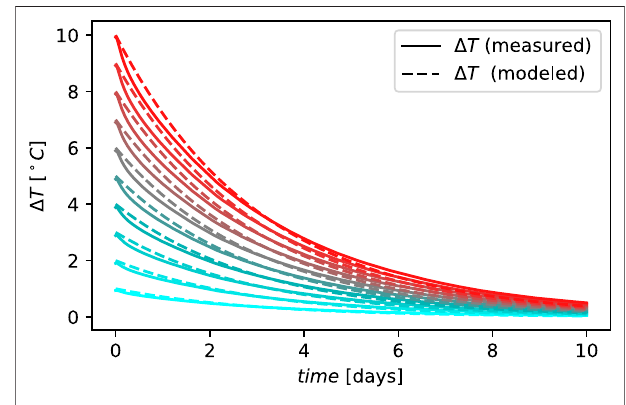
FIGURE 9 | Evolution of the average episodic return during learning for each trained agent.